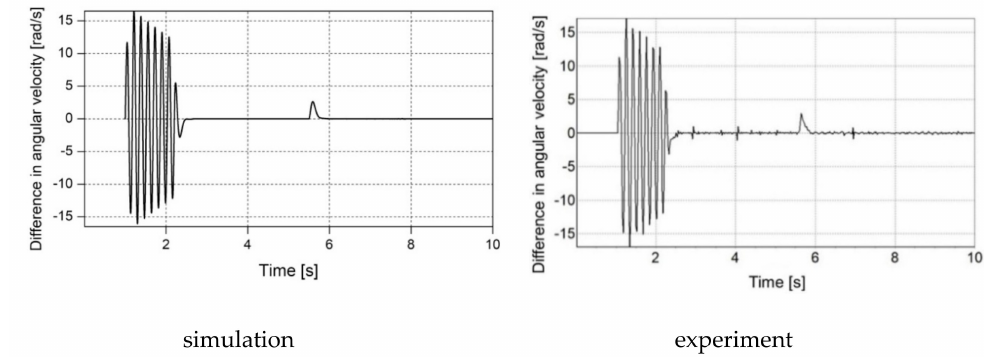
Figure 10. Di ff erence in angular velocity vs. time.